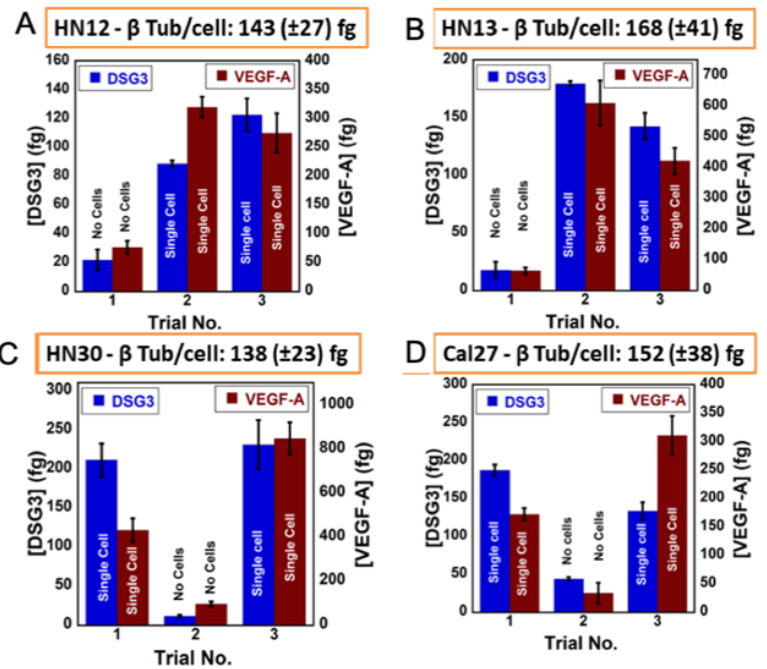
Figure 9. Protein concentrations found using online cell lysis of single cell or cell-free samples filtered and washed to remove cell culture media for cancer cell cultures ( A ) HN12, ( B ) HN13, ( C ) HN30, and ( D ) CAL27 (n = 6). Number of cells was estimated using the β -Tub concentration per single cell. Zero cell or single cell samples are marked on the graphs for DSG3 and VEGF-A. Adapted from [43], reprinted with permission. Copyright Elsevier, 2021.